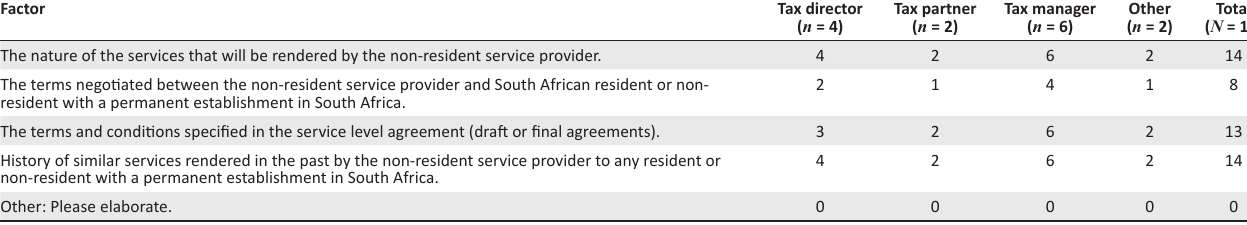
TABLE 8: Results of contributing factors that help in determining anticipated physical presence. Factor